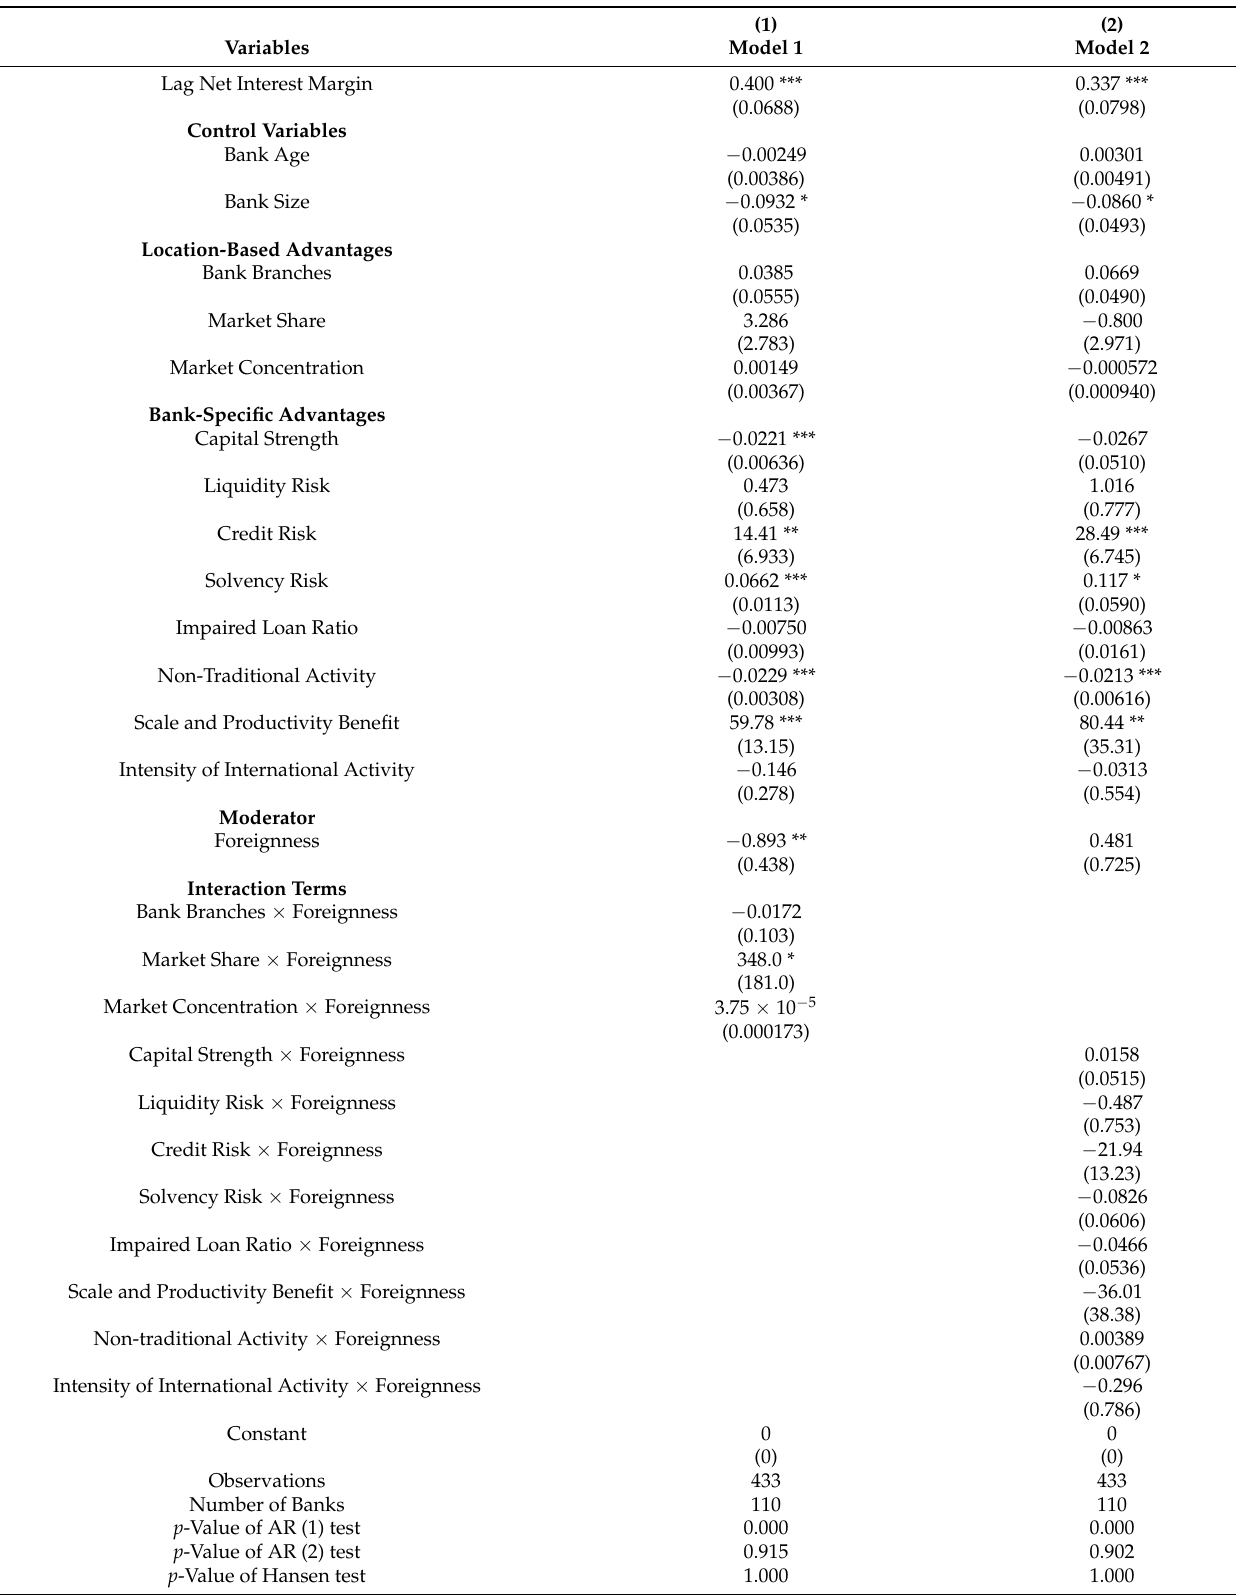
Table 6. Panel GMM model estimates